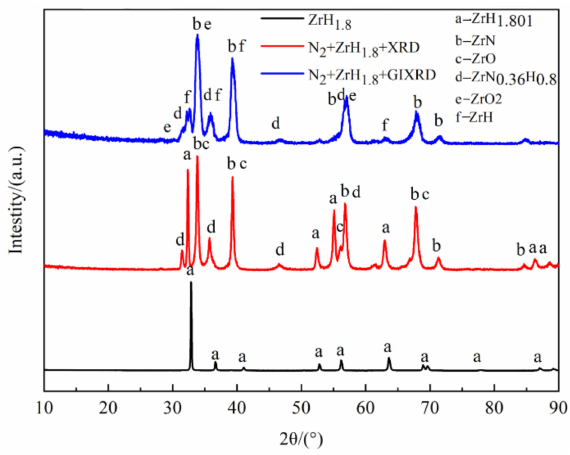
Figure 4. XRD spectrum of zirconium hydride before and after in situ reaction. Table 3. XRD results before and after in-situ reaction of zirconium hydride in nitrogen atmosphere.